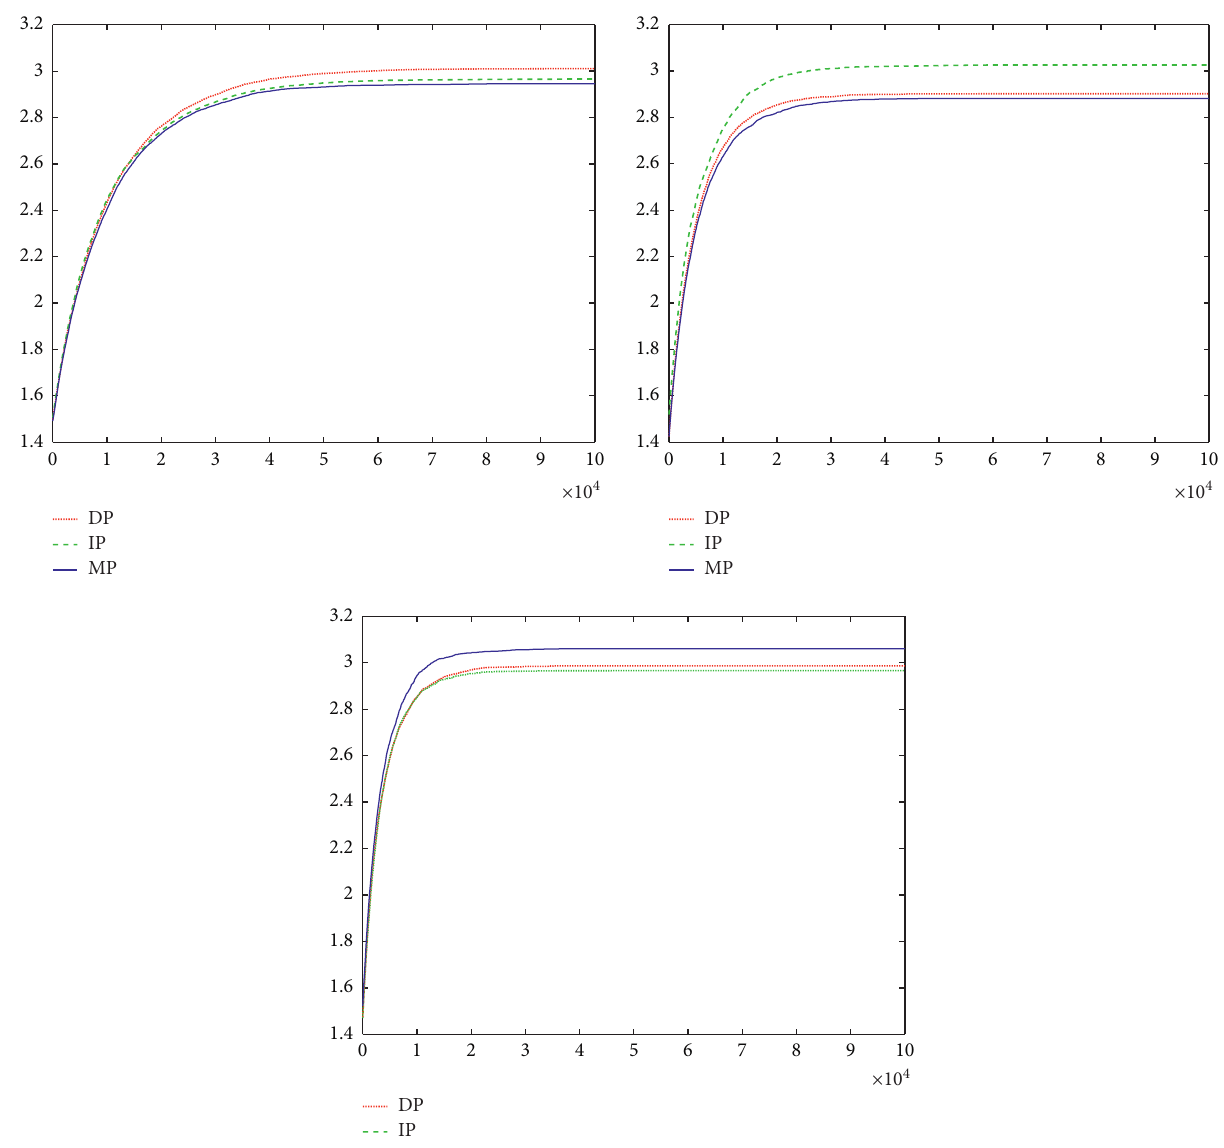
Figure 8: Average knowledge levels in a small-world network when k � 2, 4, and